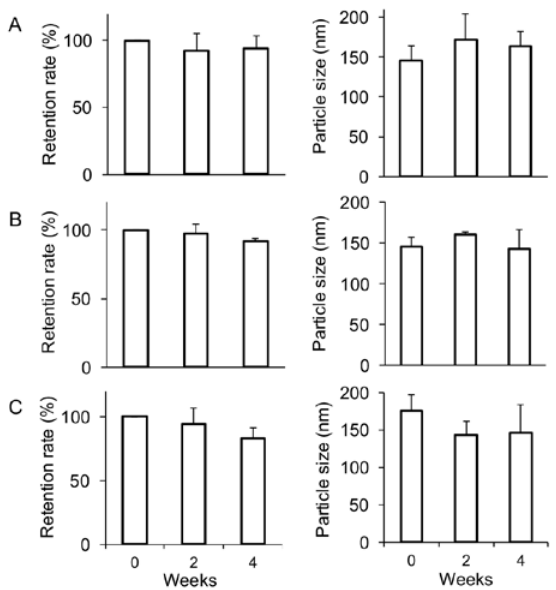
Figure 3. Stability of liposomes encapsulating taxanes at 4 °C in PBS. Stability of DTX-L ( A ) PTX-L. (B) and gPTX-L ( C ) was evaluated at 4 °C in PBS after 2- and 4-week incubation. The retained drug amounts in liposomes were estimated by reverse-phase HPLC. The distributions of particle sizes and particle number were determined by dynamic light scattering method. N = 3. Table 1. Characteristics of DTX-L and